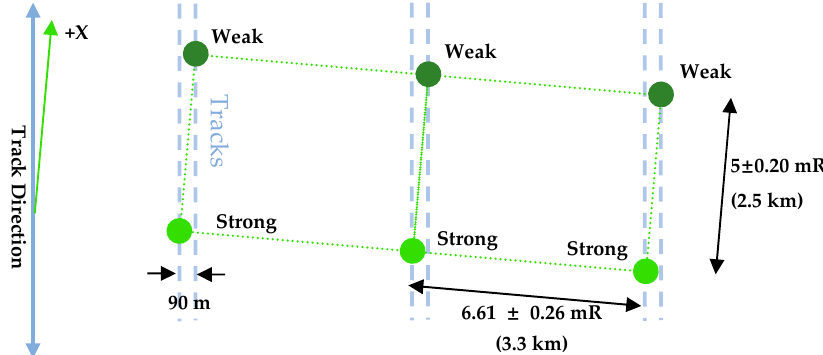
Figure 1. Ice, Cloud and Land Elevation Satellite-2’s (ICESat-2) beam pattern on the ground. The pattern has six beams organized in a 2 × 3 array. By slightly yawing the spacecraft, this will create three pairs of beams on the ground. Each pair contains a strong beam and a weak beam, with an energy ratio of 4:1. The separation for each pair is 90 m, and this can be changed by changing the yaw angle.